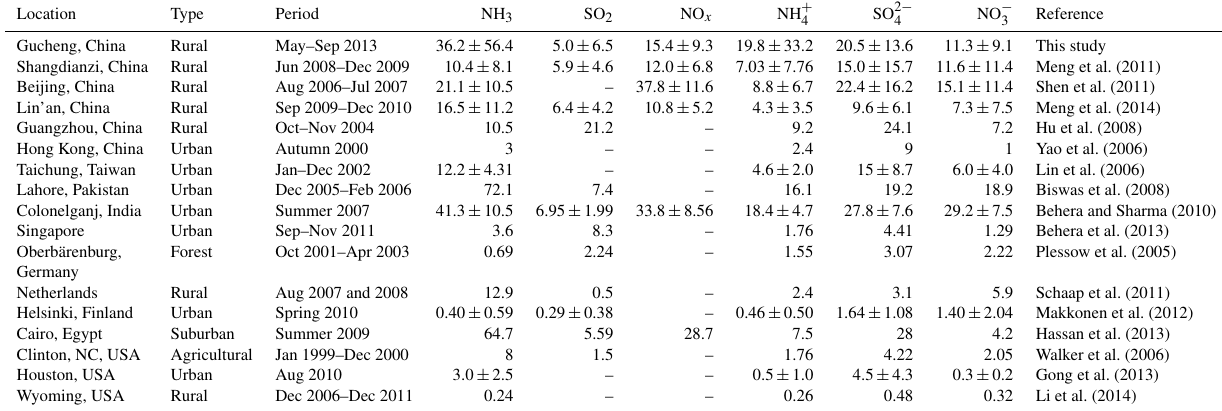
Table 1. The comparison of the concentrations of trace gases (ppb) and water-soluble ions in PM 2 . 5 (µgm − 3 ) at Gucheng with other research. Location